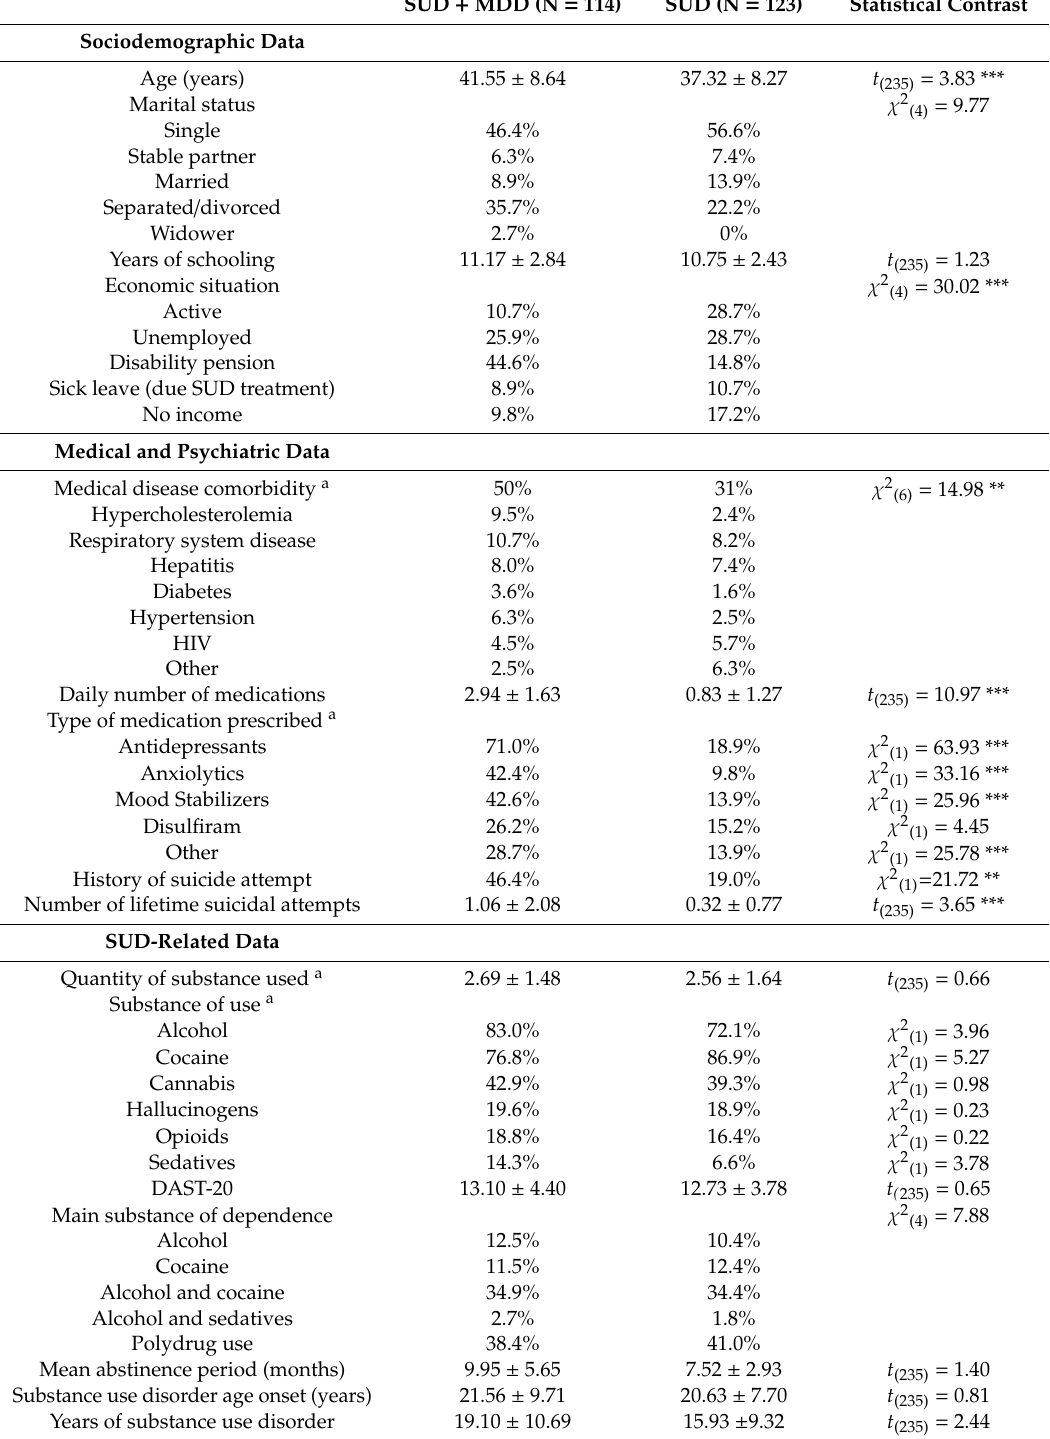
Table 1. Sociodemographic and clinical data for the two groups. Means and standard deviation or percentages, and statistical